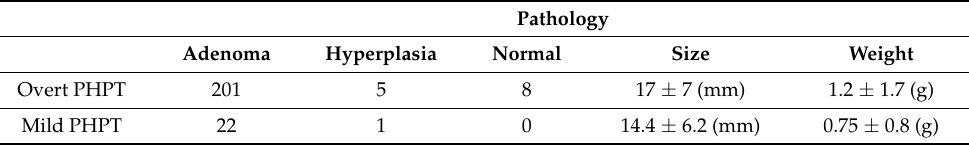
Table 4. Detailed histopathology findings of the removed glands.